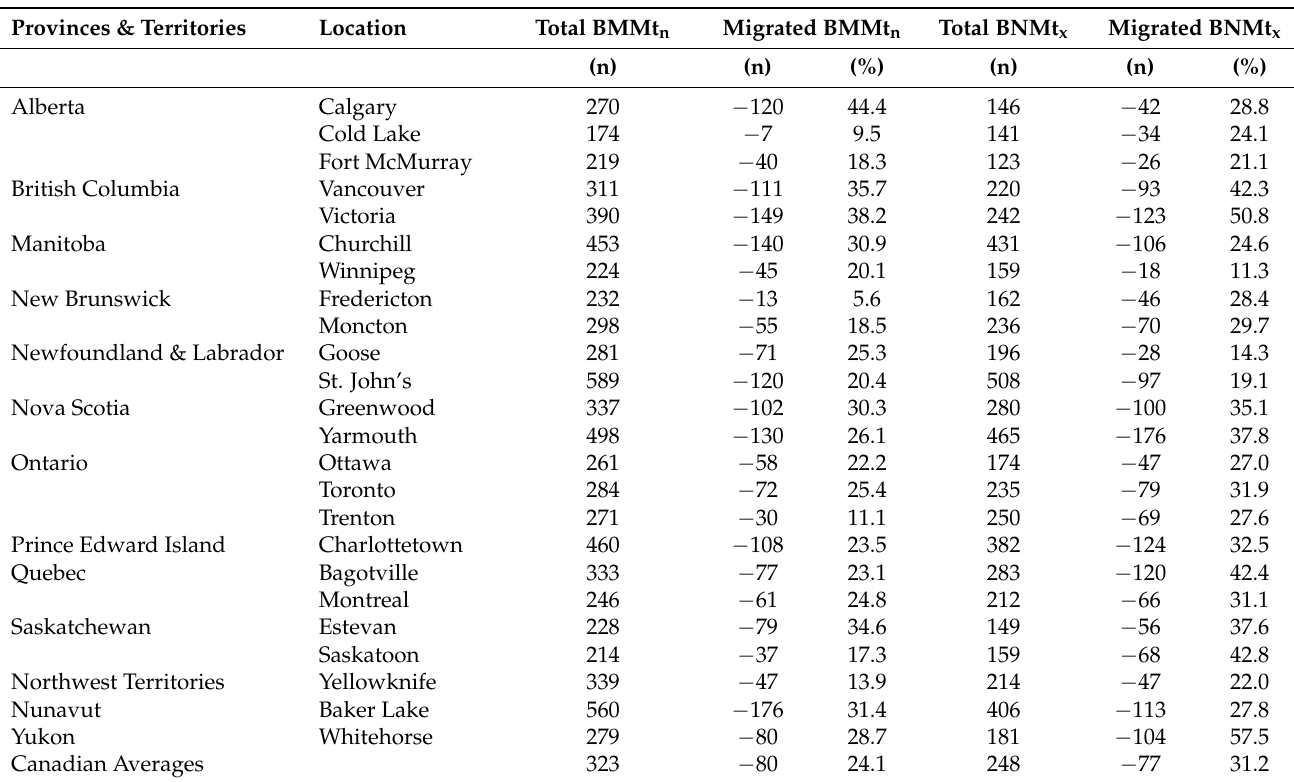
Table 4. Migration counts of the Before Midnight Minima (BMMt n ) to After Midnight Minima (AMMt n ) and of the Before Noon Maxima (BNMt x ) to After Noon Maxima (ANMt x ) between the examined 4-year averages at the beginning (1953–1956) and ending of the data range (2015–2018). Migration is expressed as counts, as well as percentages, of total